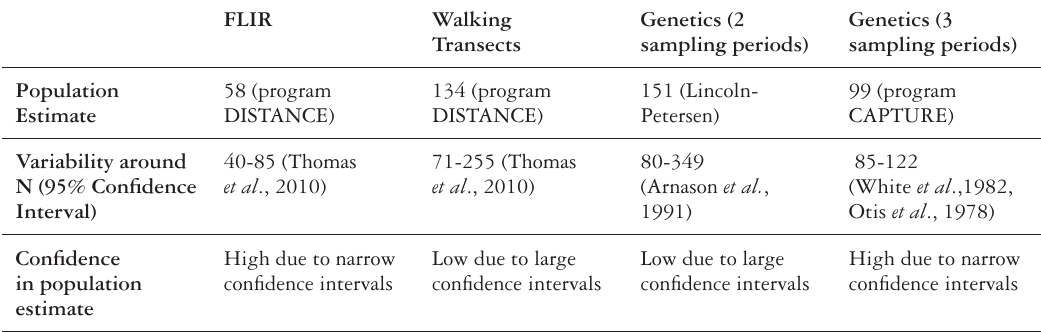
Table 1. Estimates of woodland caribou population size on the Slate Islands, Ontario, using three different techniques.